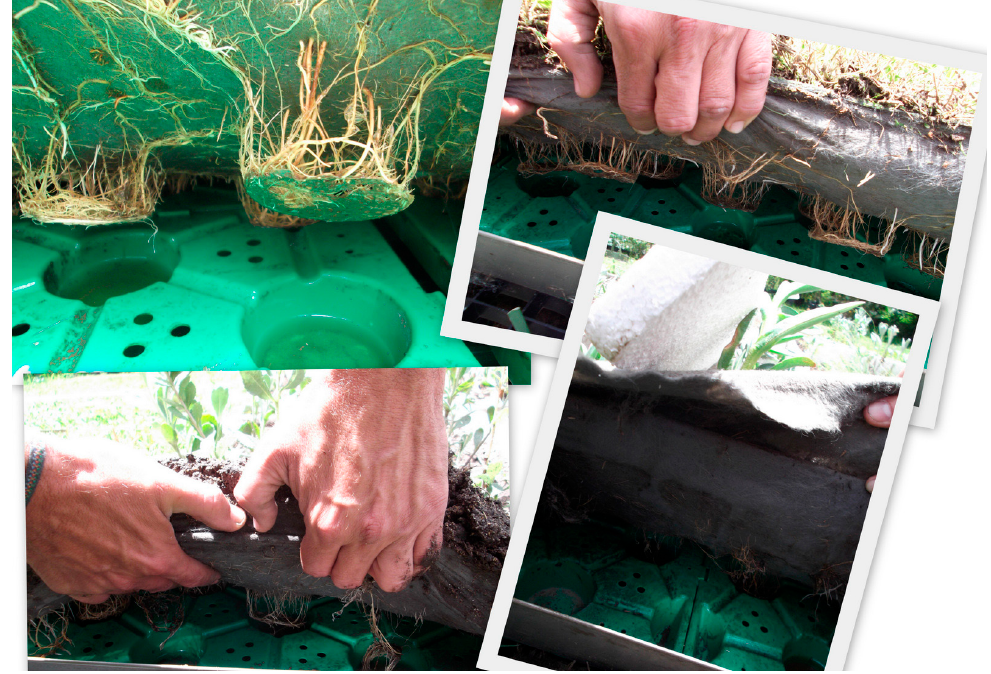
Figure 7. Green roof modules in Montevideo [31].